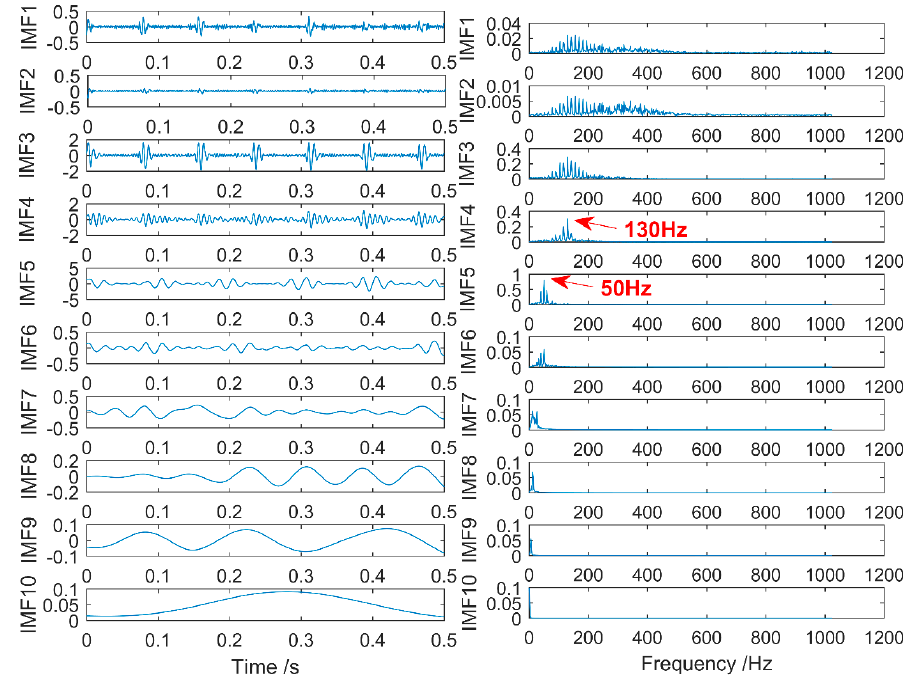
Figure 10. CEEMD decomposition reconstructed signals.